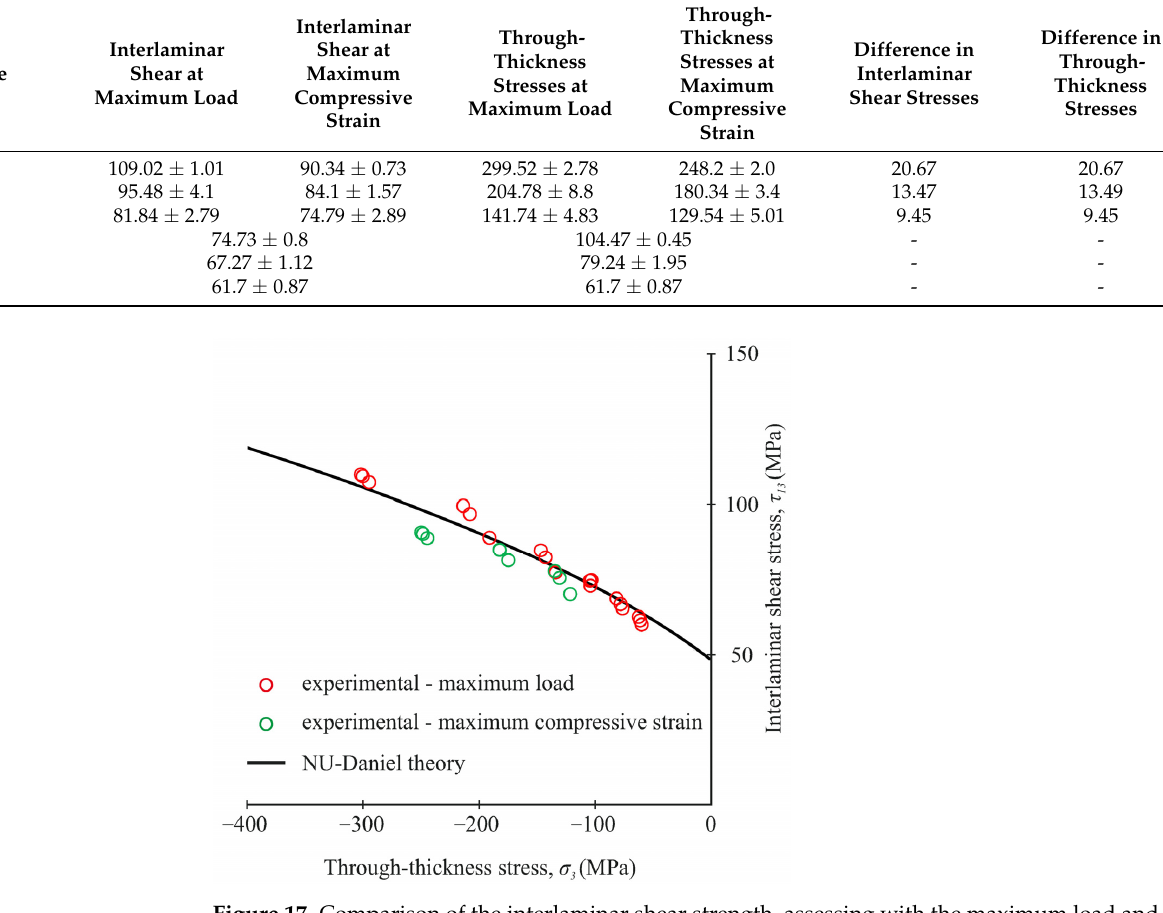
Table 3. Experimental assessment of stresses using two methods under biaxial loading.